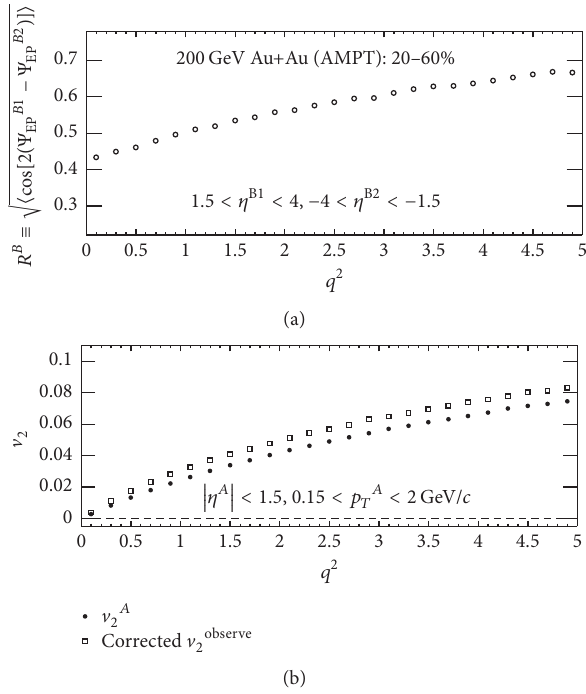
Figure 18: The subevent plane resolution (a), and the true elliptic flow V 2 A and the corrected V 2 observe as functions of 𝑞 2 (b), from AMPT simulations [51].